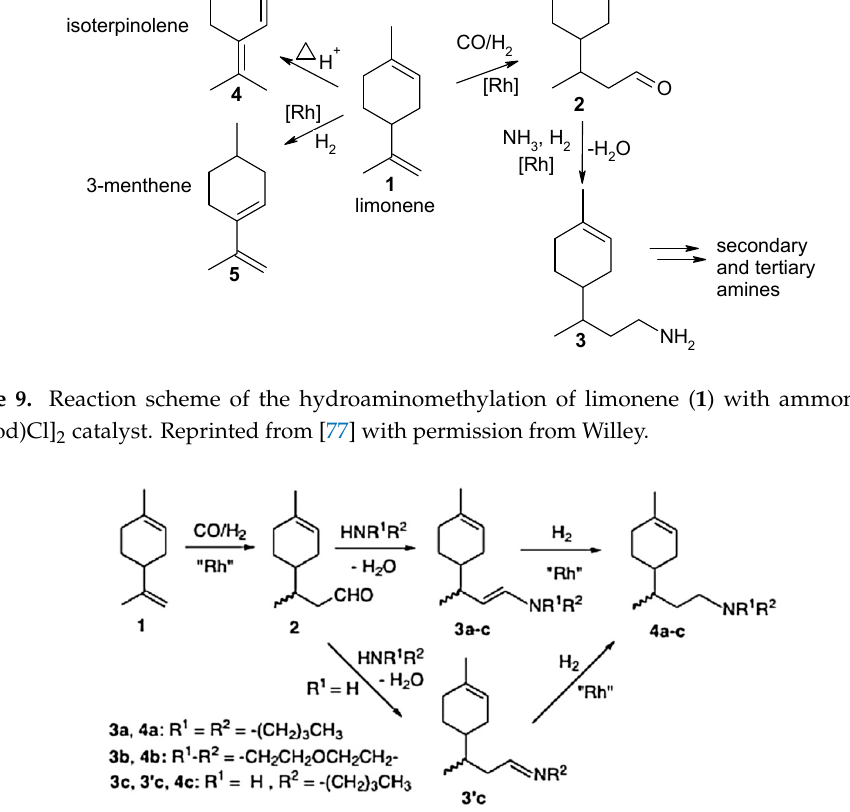
Figure 10. Hydroaminomethylation of limonene ( 1 ). Reprinted from [74] with permission from Elsevier.